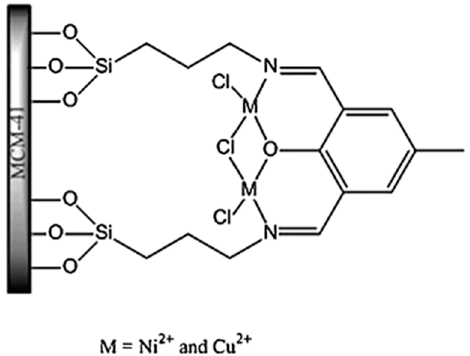
Figure 27. Schematic pattern of immobilization of DFP and related complexes. Reproduced with permission from [35]. Copyright 2017 Springer.